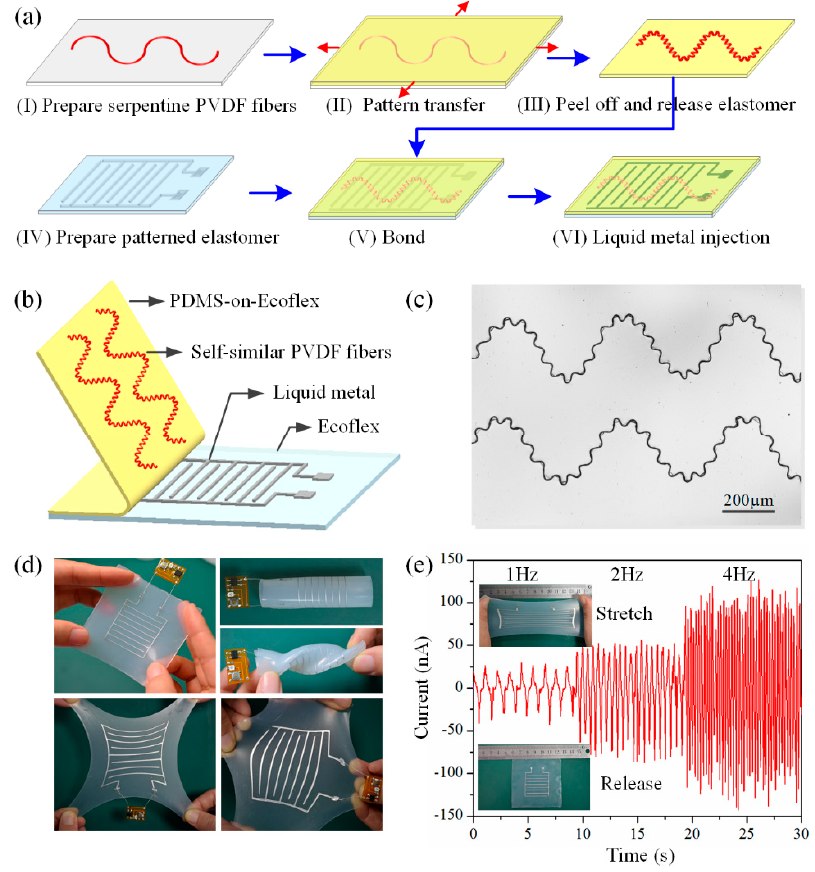
Figure 1. ( a ) Fabrication process of the stretchable nanogenerator; ( b ) Schematic diagram of the stretchable nanogenerator with fractal micro/nanofibers; ( c ) Optical image of fractal PVDF micro/nanofibers; ( d ) Photographs of the nanogenerator under various deformations, including bending, twisting, and uniaxial/biaxial stretching; ( e ) Output currents of the nanogenerator with different stretch and release frequencies under an applied strain of 200%.